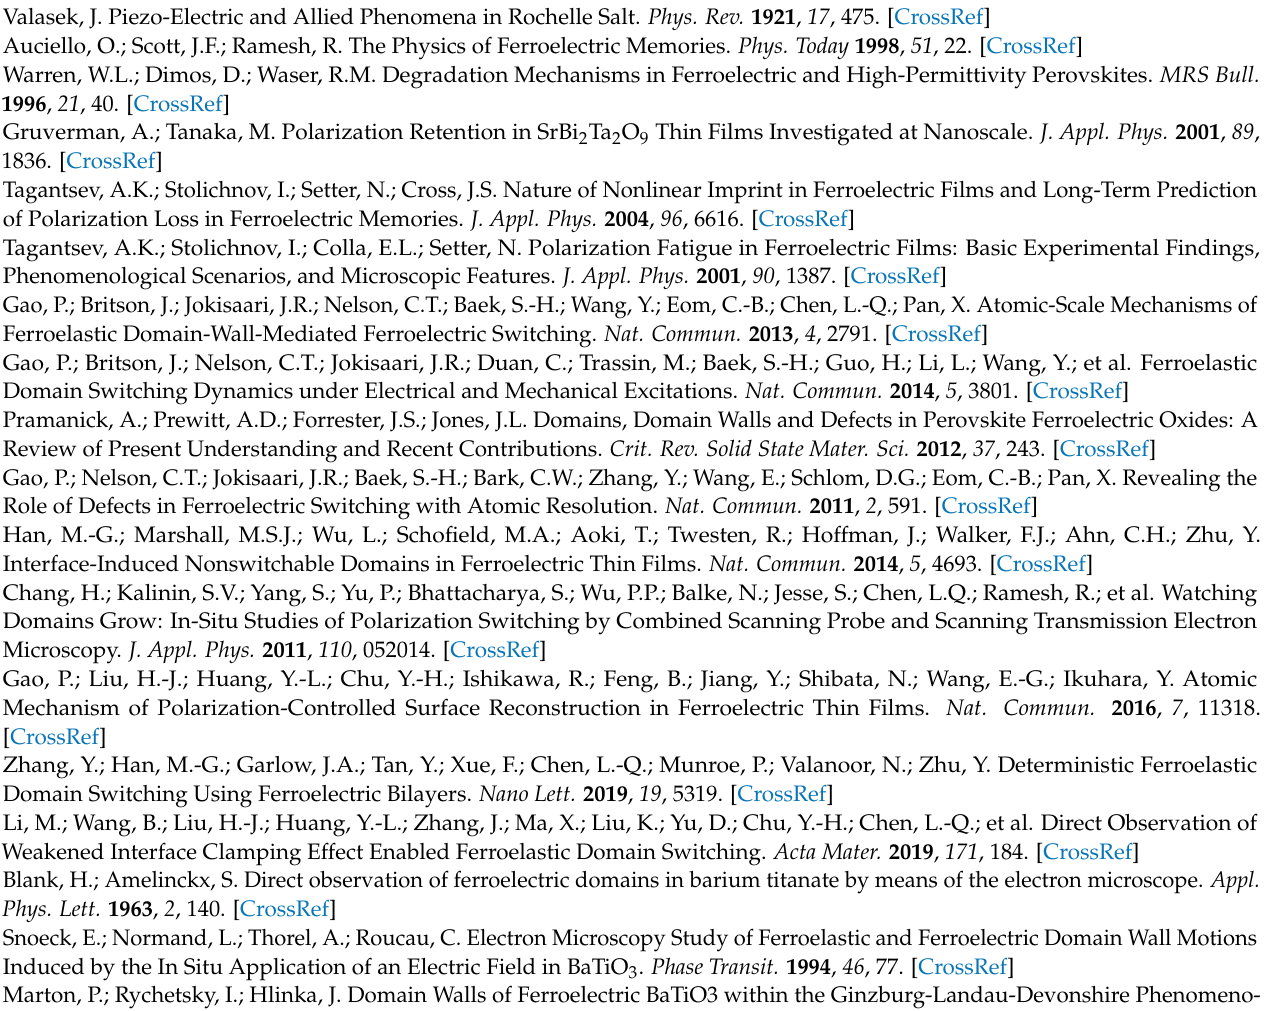
Figure S2: (a) Atom column fitting and (b) extracted PZT lattice parameters, Video SV1: 4-segmented detector data and resulting DPC image of the in situ electrical biasing